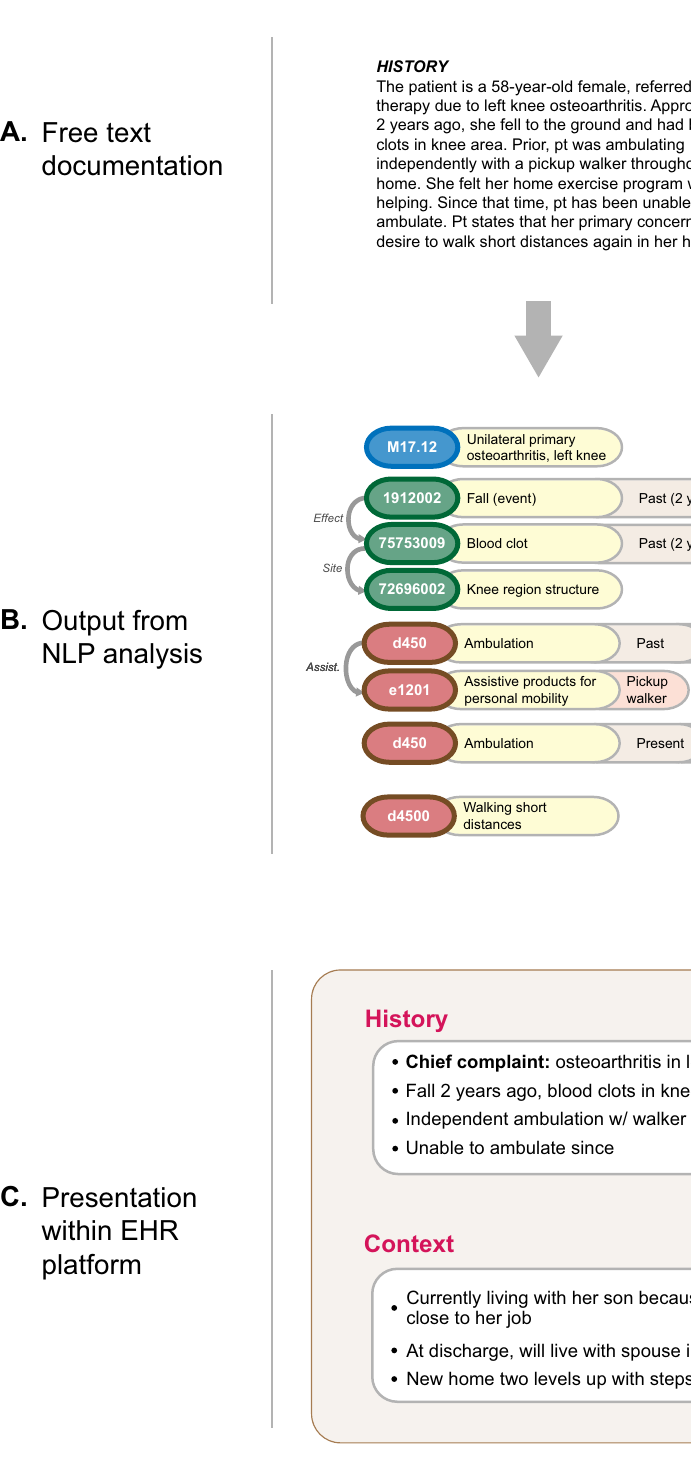
Fig 5. Conceptual illustration of the use of NLP to analyze and organize complex information recorded in free text clinical notes. Panel (A): Two example free text notes with important information about a patient’s situation. Panel (B): Example output of an NLP system designed to extract and standardize pieces of information described in text, such as medical events, diagnoses and symptoms, functional outcomes, and contextual factors. The individual steps of the NLP pipeline are omitted for brevity. Panel (C): This information can then be used for a variety of purposes, from recommendation of therapeutic interventions to organizing key information into an EHR dashboard for quick review in patient care (as illustrated in the mock dashboard here). EHR, electronic health record; NLP, natural language